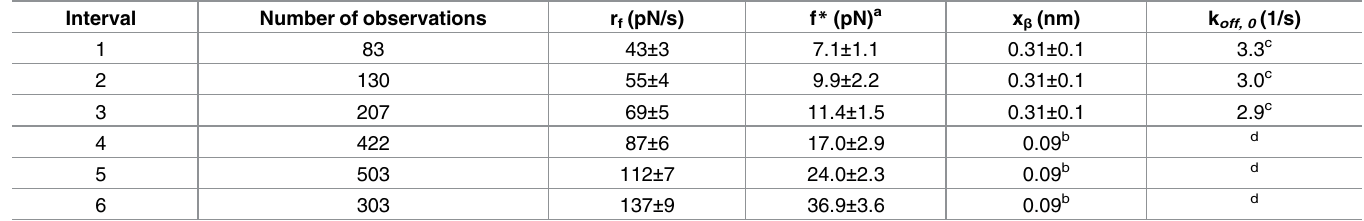
Table 3. Estimated parameters characterizing the energy landscape of the MUC1(STn)—MGL interaction.